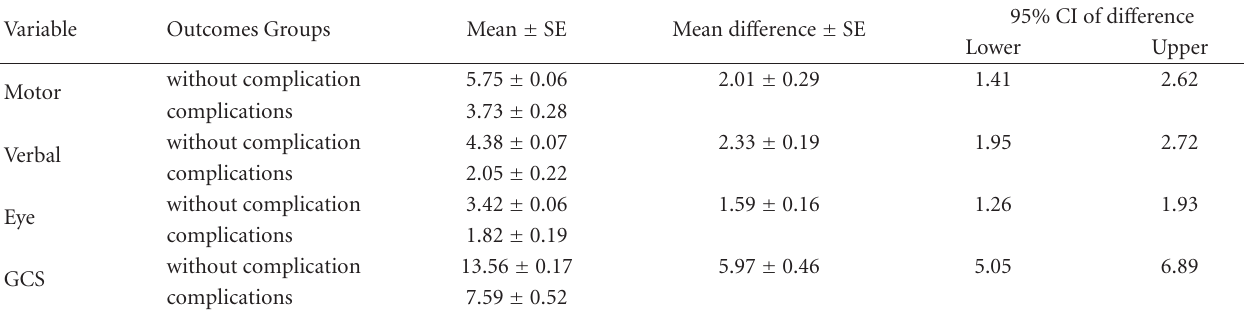
Table 3: The mean value of GCS and its components in patients with MDP with respect to outcomes. Variable